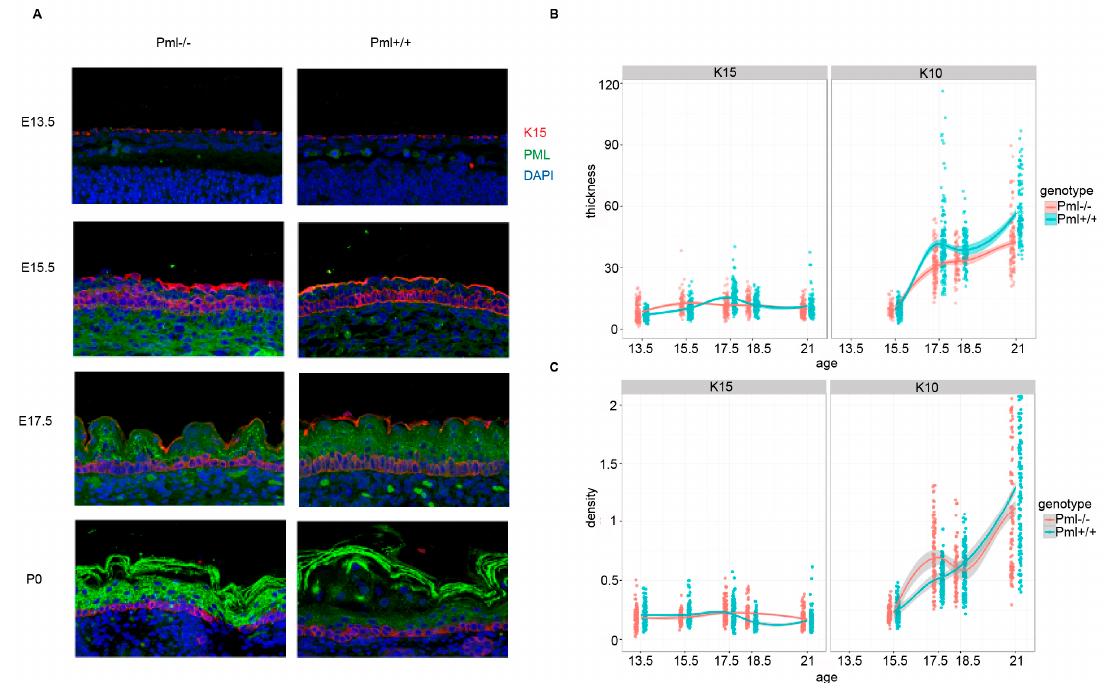
Figure 4. PML affects epidermal thickness during embryogenesis. ( A ) Representative sagittal images of epidermis derived from PML-wt and PML-KO E13.5, E15.5, E17.5, and P0 mice. Sections were IF-labeled using antibodies against K15 (red) and K10 (green). DAPI is shown in blue. The images represent projections of multiple confocal Z-stacks. ( B ) Quantification of epidermal thickness. The plotted lines represent average thickness (±STD) of K15 and K10-positive epidermal layers. Each data point represents measurements from a single microscopic field. More than 50 microscopic fields from 5–7 embryos/newborn mice per developmental stage were analyzed. ( C ) Quantification of cell density in basal and spinous layer of epidermis at different stages of embryonic development. Data are represented as aforementioned in ( B ).